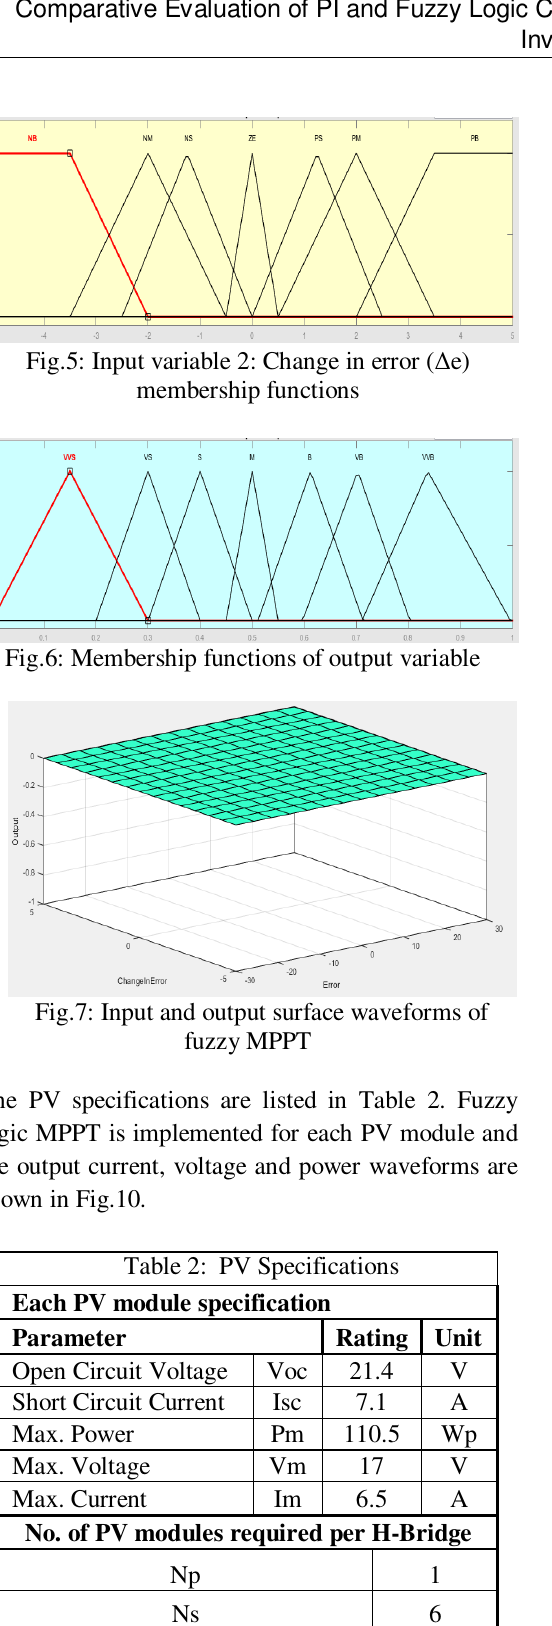
Fig 9: DC link voltage